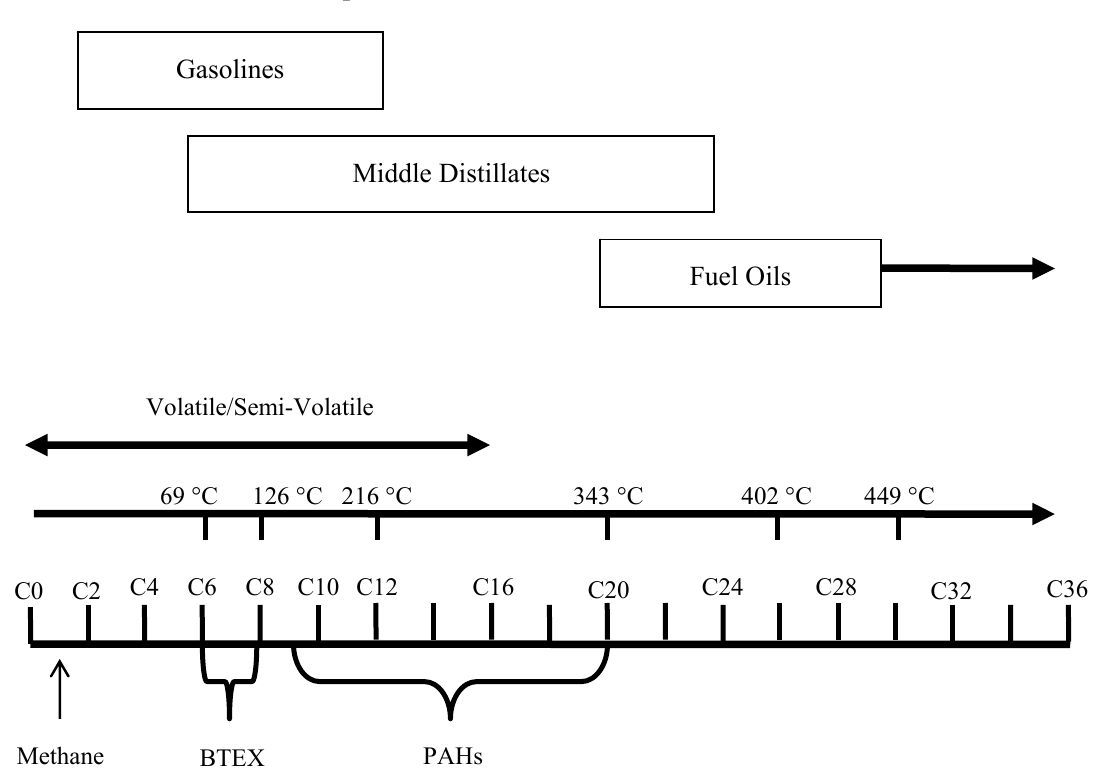
Figure 1. Composition of typical petroleum fuels with respect to the number of carbon molecules in individual